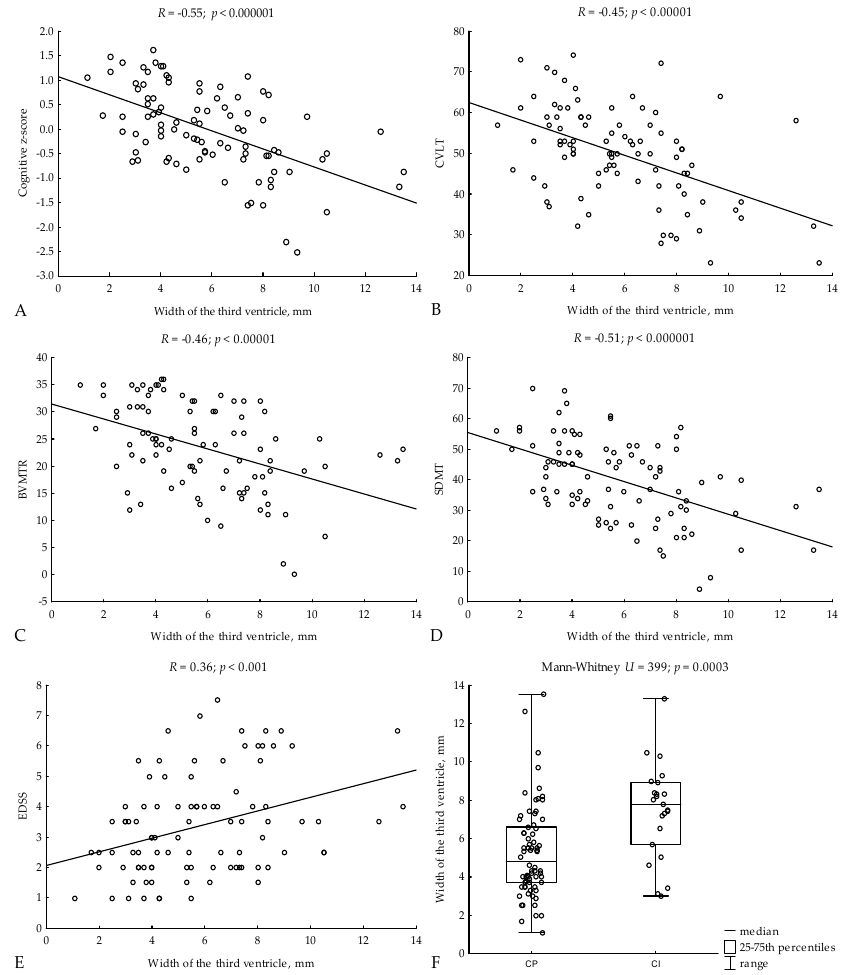
Figure 1. Relations of 3VW to cognitive z-scores ( A ), CVLT ( B ), BVMTR ( C ), SDMT ( D ), and EDSS ( E ). 3VW in CI and CP patients ( F ). R—Spearman’s rank correlation coefficient, CVLT—Californian Verbal Learning Test, BVMT-R—Brief Visuospatial Memory Test—Revised, SDMT—Symbol Digit